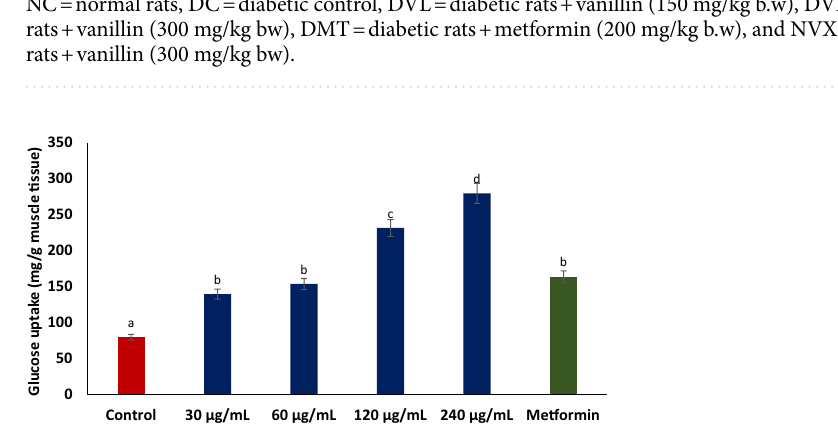
homeostasis and oxidative stress in diabetic muscles leading to their dysfunction. The reduced lipase activity (Fig. 8) restored FFAs metabolites (Table 1) and reactivated pathways (Table 2 and Fig. 11) in T2D rats treated with low dose of vanillin (DVL) indicates the ability of the phenolic acid to improve muscle lipid metabolism at low dose. Thus, suggesting a metabolic switch to glucose for muscle energy production which correlates with the